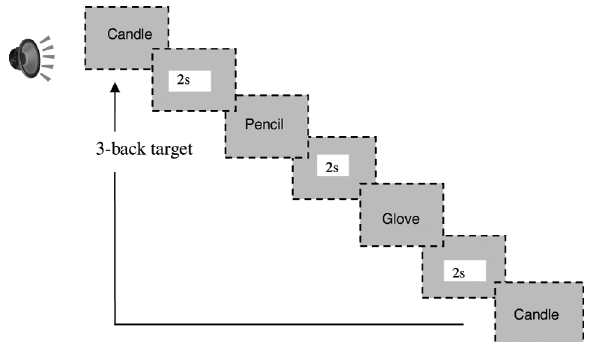
Figure 1. Presentation of